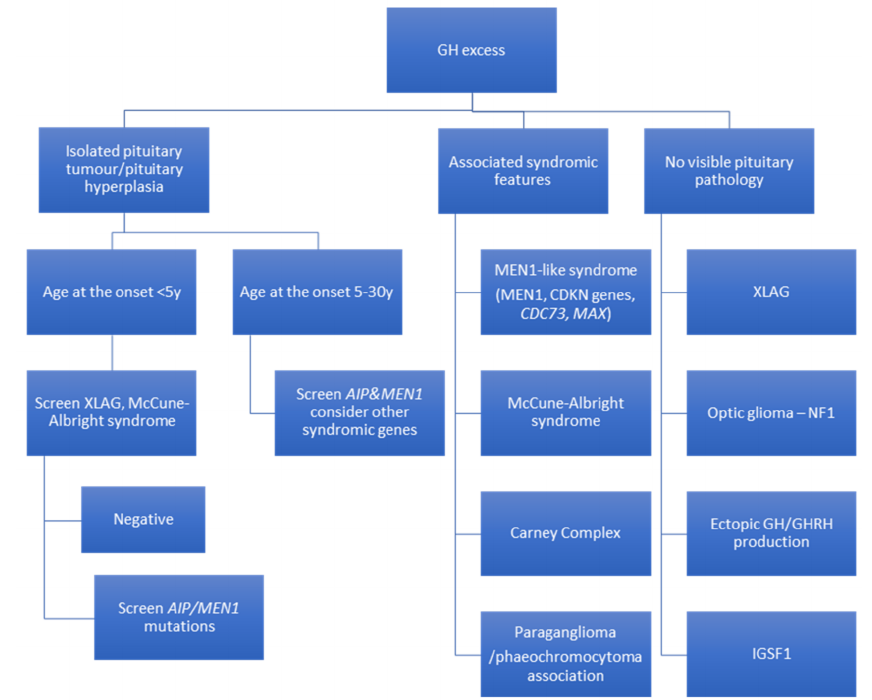
Figure 1. Suggested algorithm of genetic screening of GH excess. GH, growth hormone; GHRH, growth hormone releasing hormone; XLAG, X-linked acrogigantism; AIP, aryl hydrocarbon receptor- interacting protein; MEN1, multiple endocrine neoplasia type